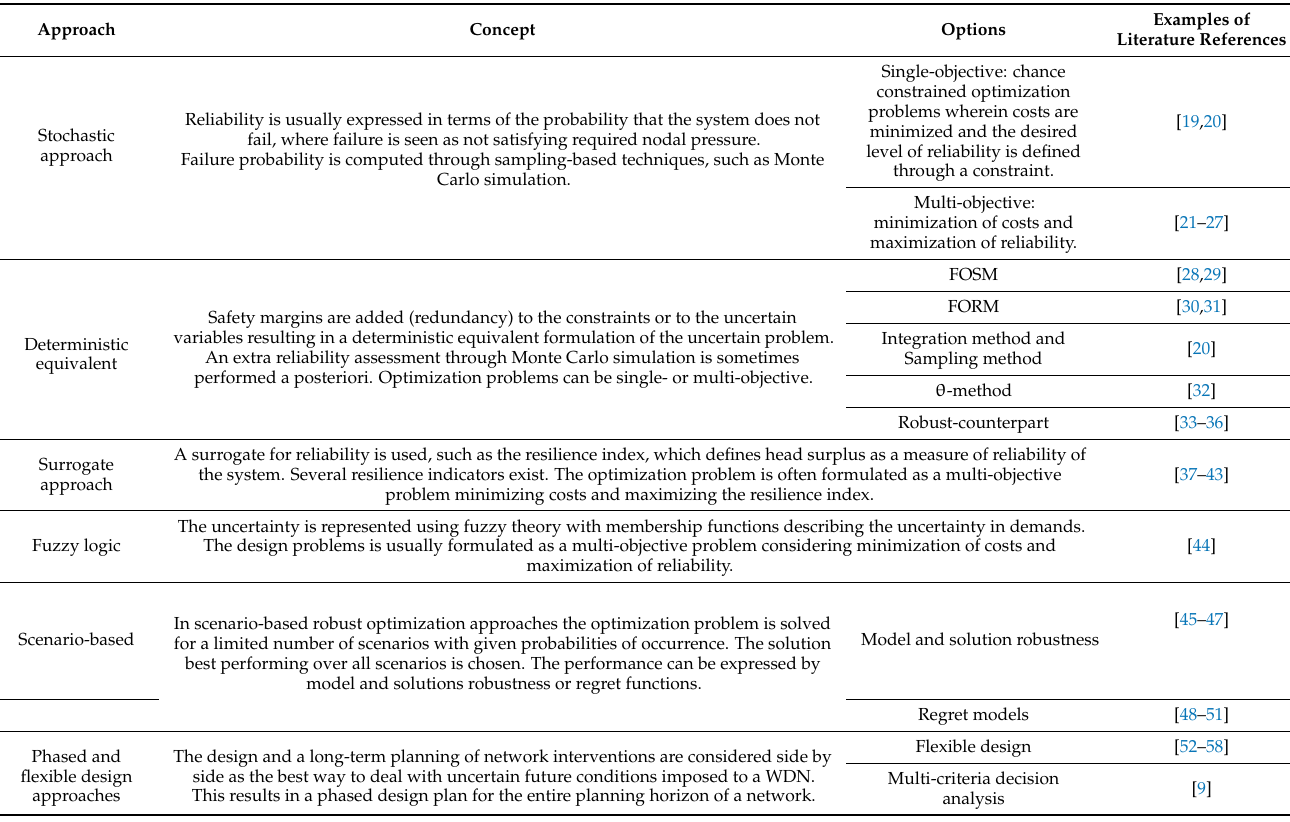
Table 1. Concise overview of approaches for the design of WDN that include uncertainty in the decision process.